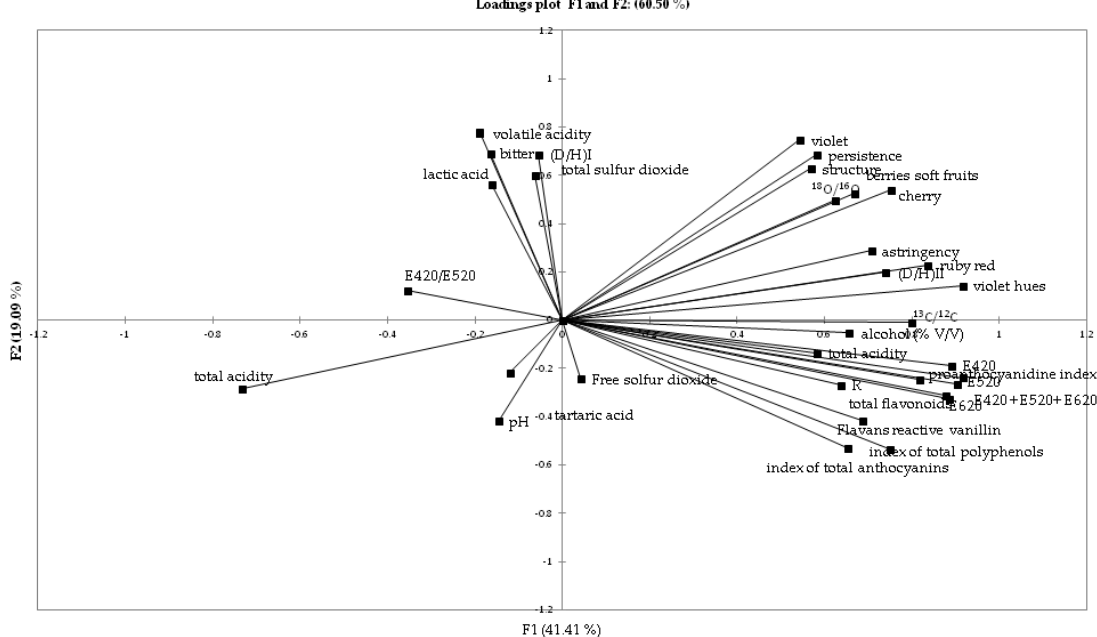
Figure 6. Loadings plot for white wines (Nero d’Avola and Refosco) in the two vintages